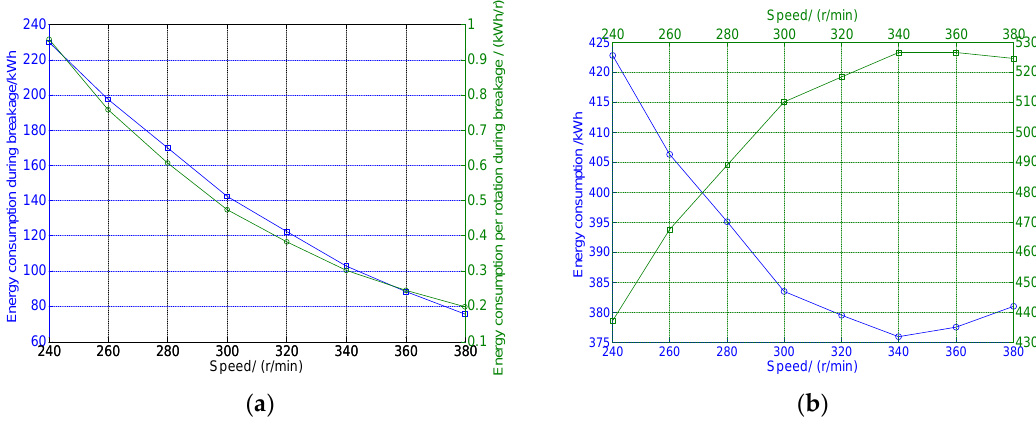
Figure 8. Energy consumption and production when varying speed: ( a ) relation of speed vs. energy consumption during breakage; ( b ) relation of speed, production and energy consumption.